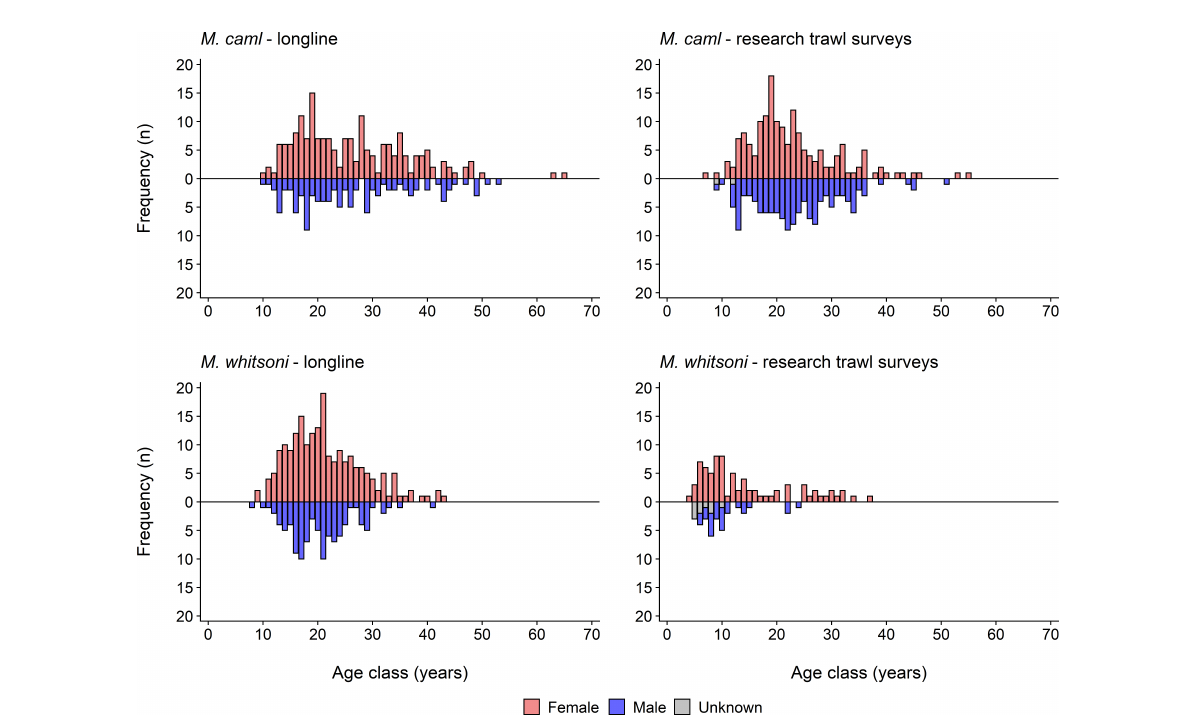
FIGURE 4 Age frequency distributions for female, male and unsexed Macrourus caml (top row) and M. whitsoni (bottom row) sampled from the Ross Sea region by the commercial longline fi shery (left column), and fi sheries-independent research trawl surveys in 2019 (right